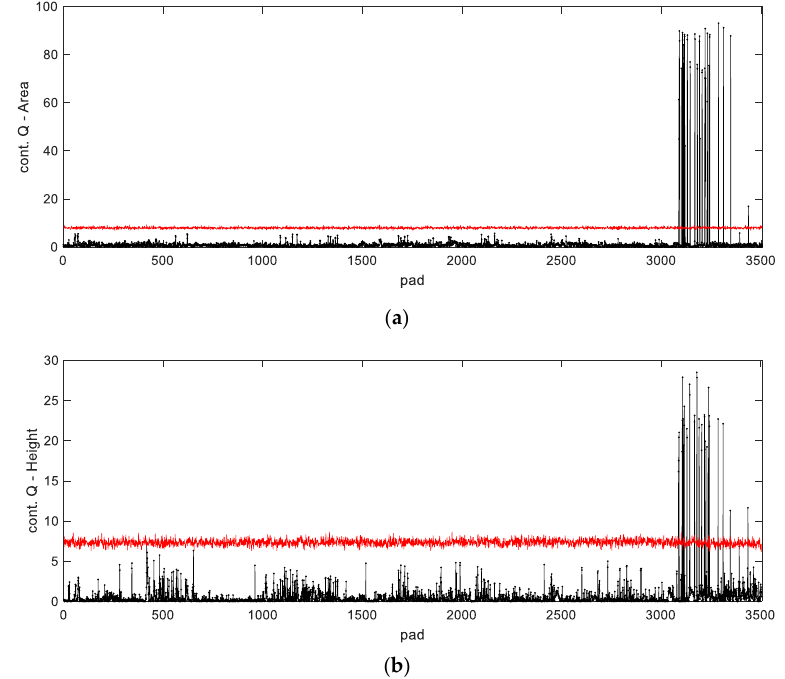
Figure 15. Contribution of each pads’ parameter to the Q -statistic of PCB #159 of CS2: ( a ) contributions for the pads’ area; ( b ) contributions for the pads’ height.